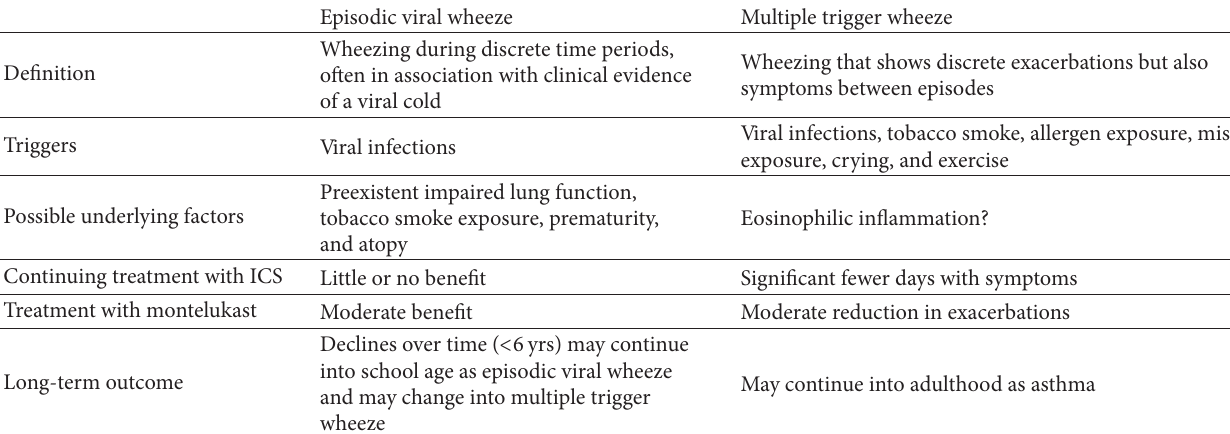
T 1: Characteristics of episodic viral wheeze and of multiple trigger